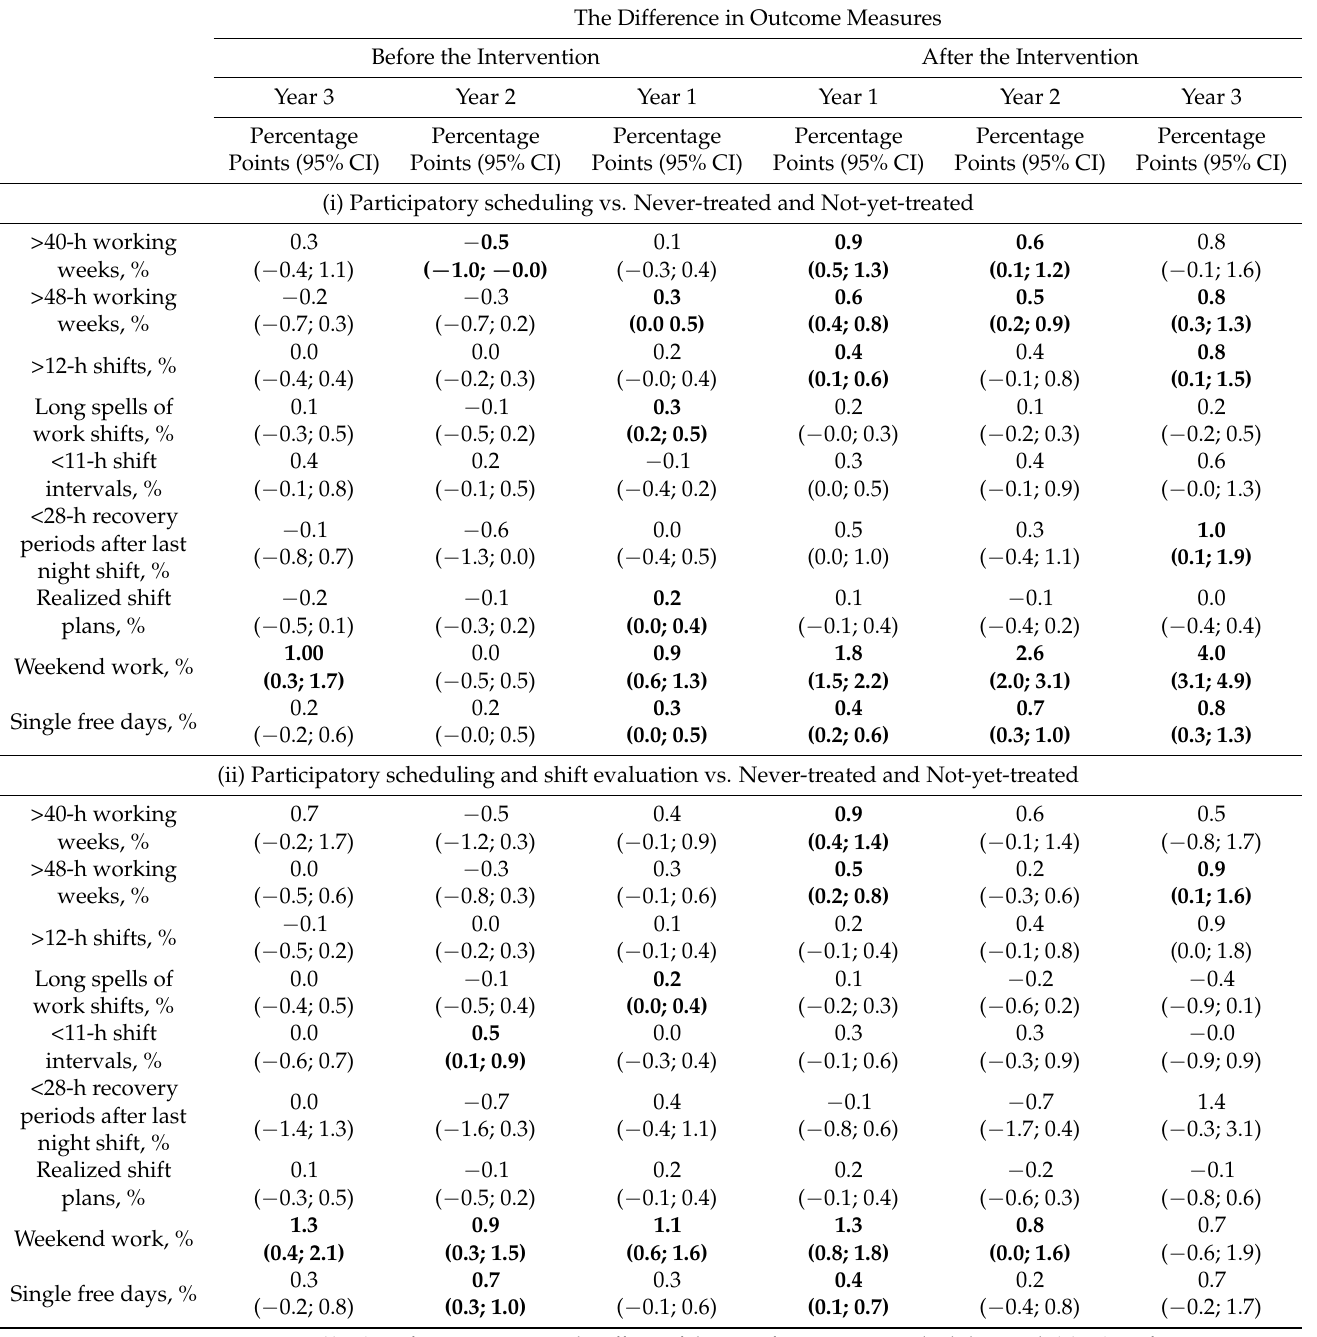
Table 2. The estimated effects of the use of the participatory scheduling tool and the shift schedule evaluation tool on the occurrence of various shift work characteristics. Event study estimates with ward-level clustered standard errors. Statistically significant differences are